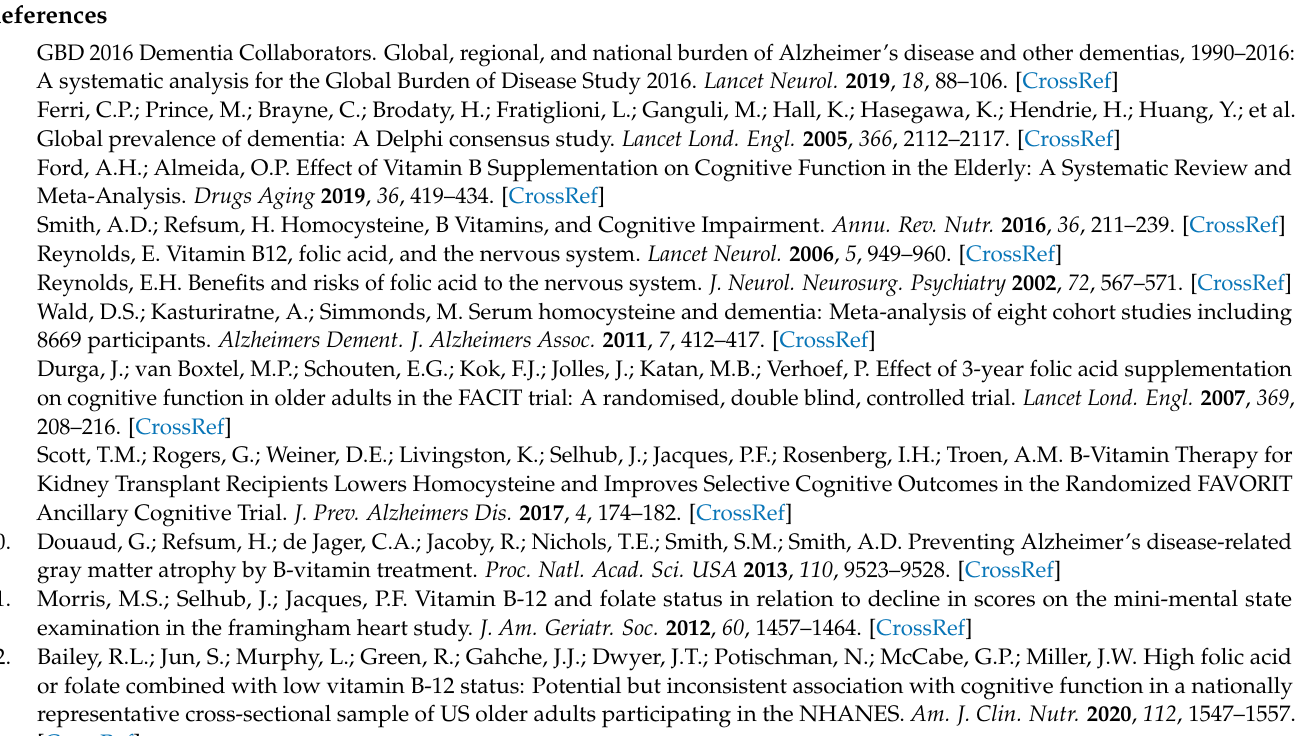
and vitamin B12 status; Figure S1: Flowchart illustrating sample stratification; Figure S2: Association between folate status and cognitive performance in normal vitamin B12 status; Figure S3: Association between folate status and cognitive performance in low vitamin B12 status; Figure S4: Elbow plot and mean silhouette coefficients